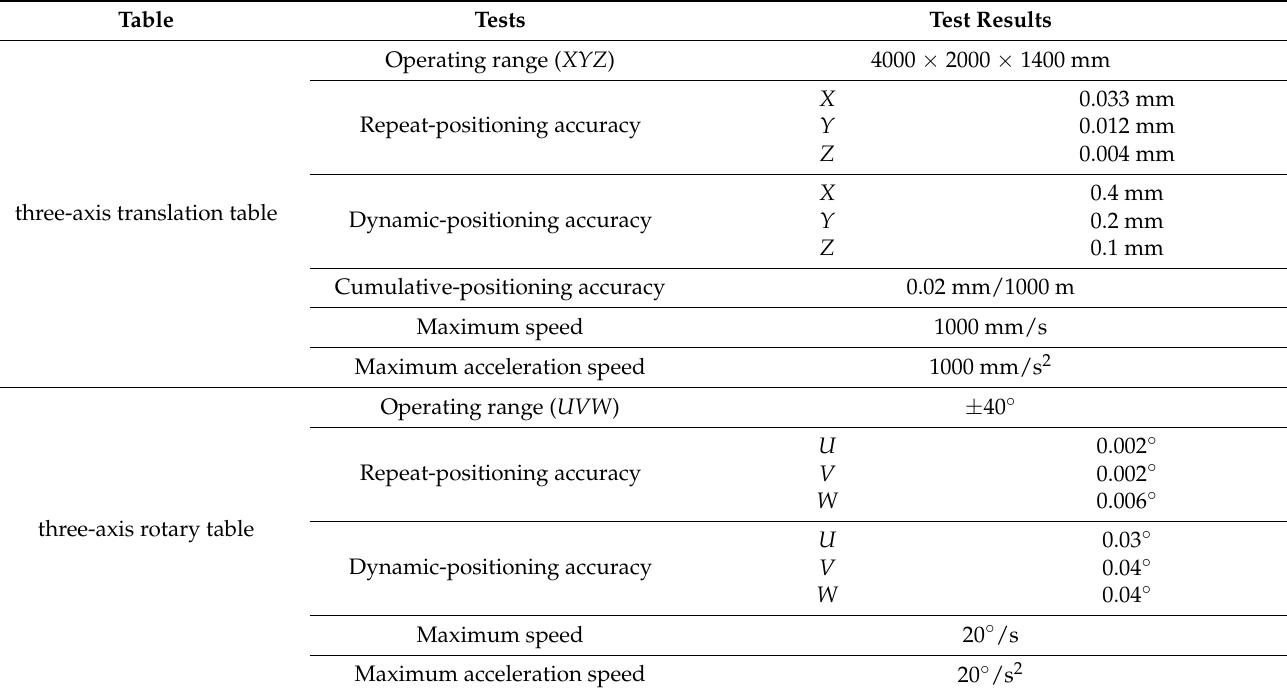
Figure 16. Repeat-positioning-error-test results: ( a ) U -axis, ( b ) V -axis, ( c ) W -axis. Table 4. Steady-state performance test Table 4. Steady-state performance test results.